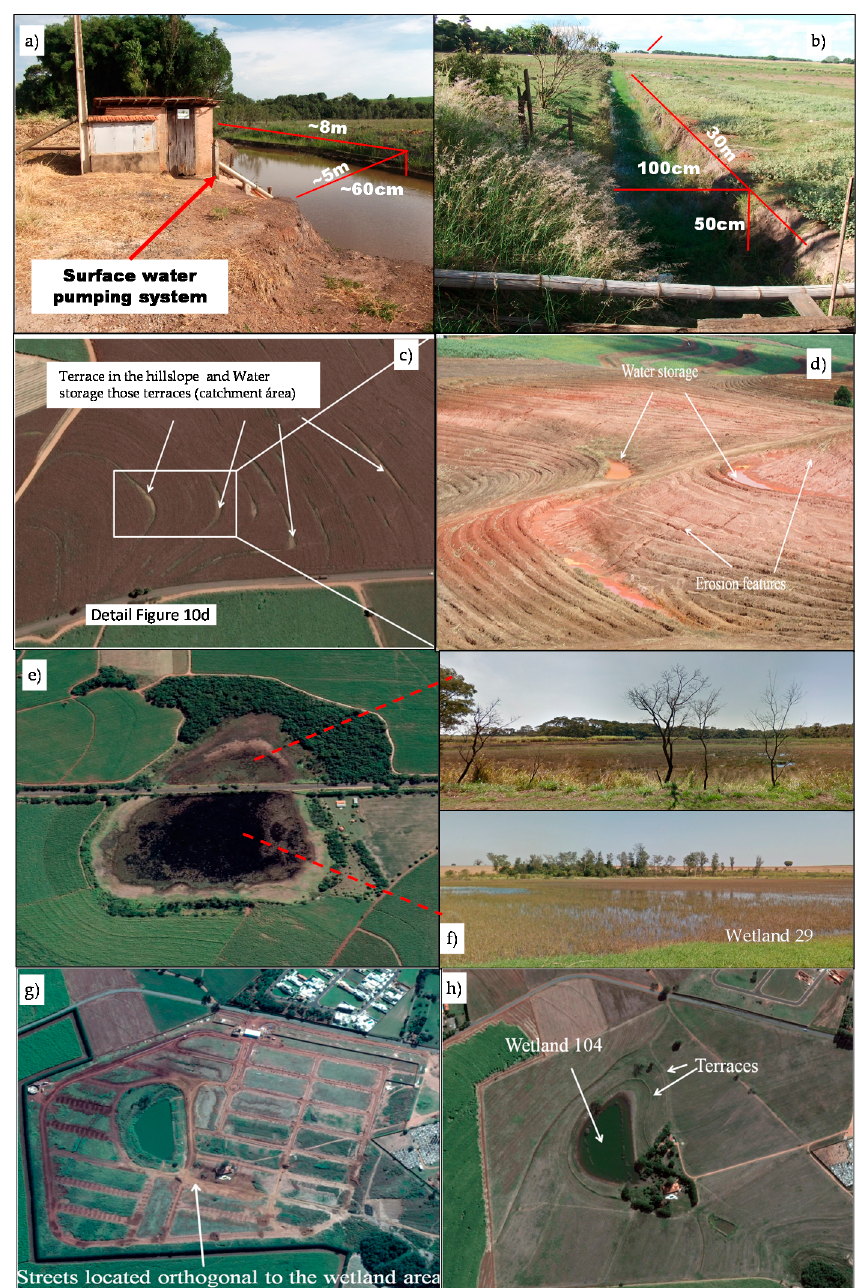
Figure 11. Evidence and examples of anthropogenic interferences: ( a ) wetland that was excavated to extract water for agriculture; ( b ) artificial drainage channel (ditches); ( c ) terraces in the catchment area; ( d ) detail of Figure 11c showing water storage due to terraces in the catchment area; ( e ) effect of road construction on stored water of Wetland 29 (06/2019); ( f ) photograph showing details of the road construction effect, in which one side displayed more water than the other; ( g , h ) changes in Wetland 104 caused by urbanization in July 2010 and June 2017.